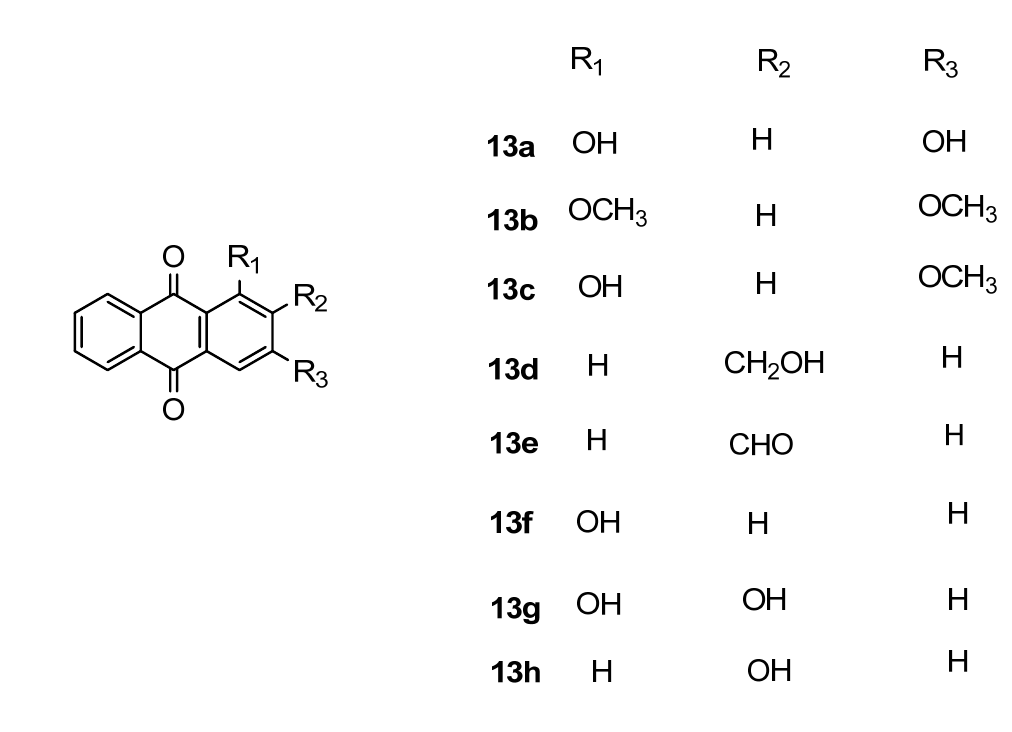
Figure 2. Structure of compounds 13a to 13h